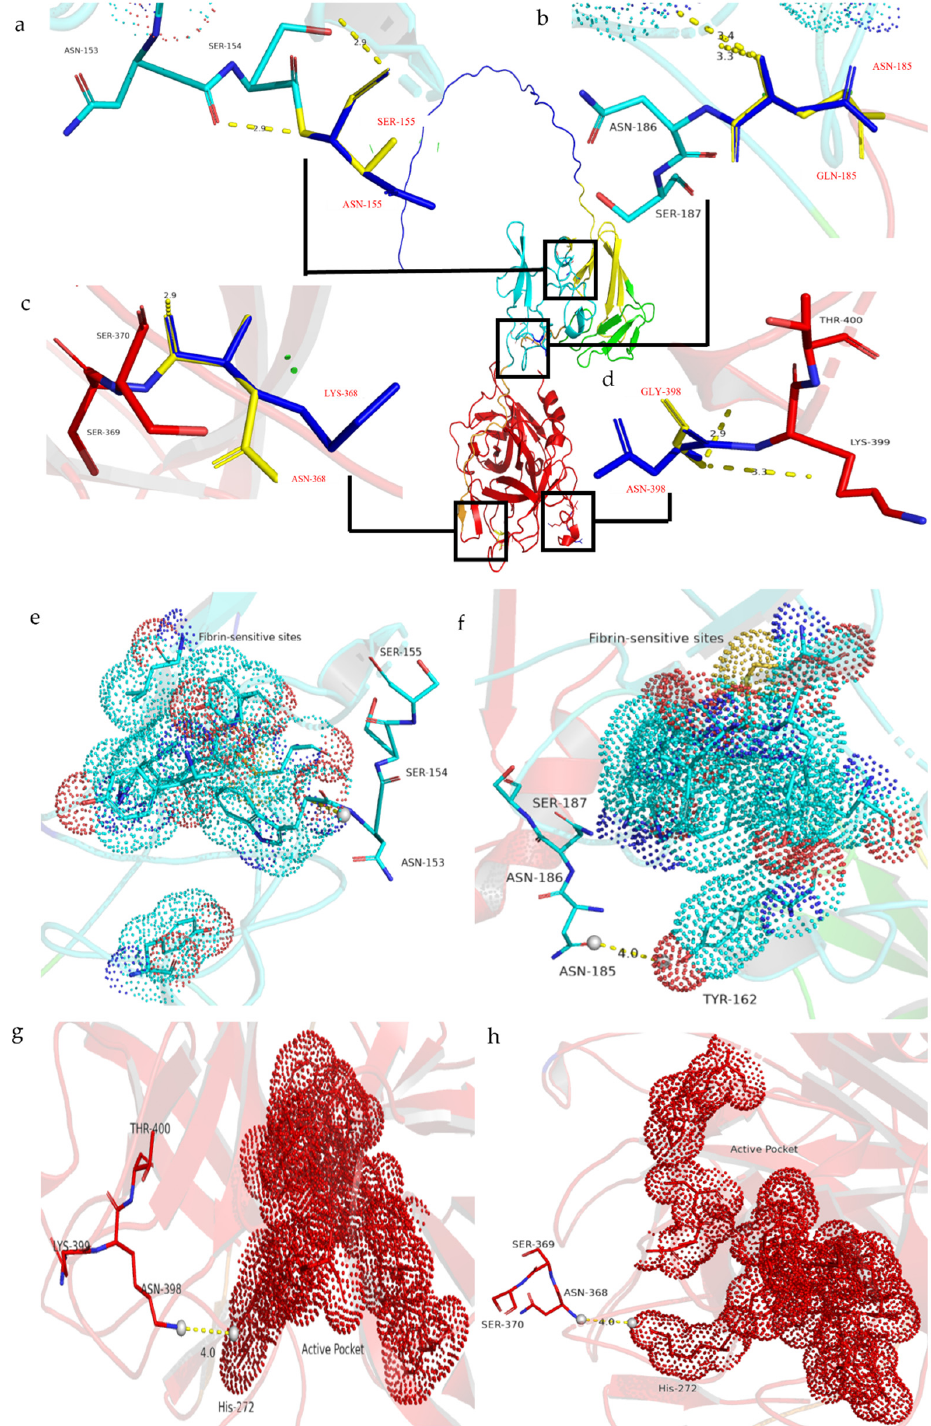
Figure 3. The residue interaction distance before and after mutation. ( a – d ) The blue sticks represent the original amino acid, the yellow sticks represent the mutated amino acid, and the yellow dotted line represents all of the polar distances of the sites: ( a ) N153 (N155S); ( b ) N185Q; ( c ) K368N; and ( d ) N398Q. ( e – h ) The sporadic dots represent the active surfaces of the sites, the blue and red dots indicate the ligand-binding sites, and the red dots denote the active pocket. The yellow dotted line represents the polar distance between the two linked atoms, and the sticks represent the selected glycosylation sites. Different colors indicate that they are in different domains: ( e ) N153(N155S); ( f ) N185Q; ( g ) K368N; and ( h ) N398Q.